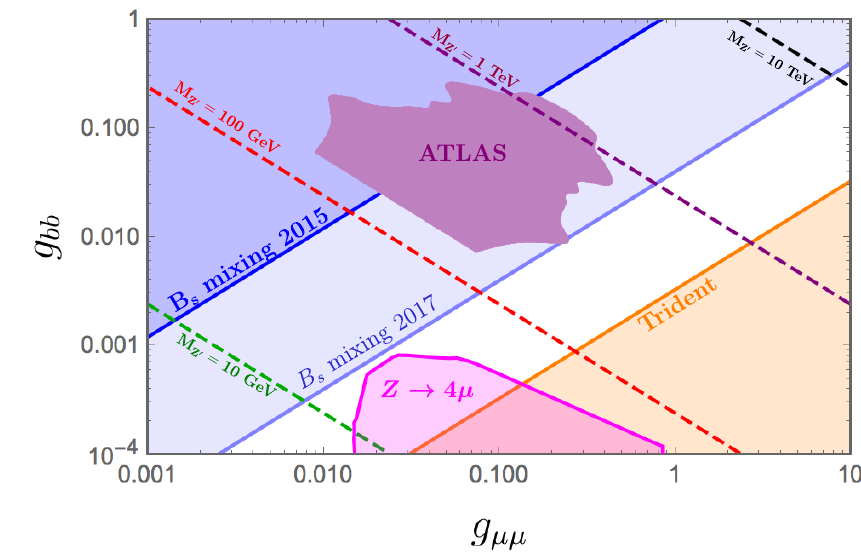
anomalies and (cid:13)avour K ( (cid:3) )